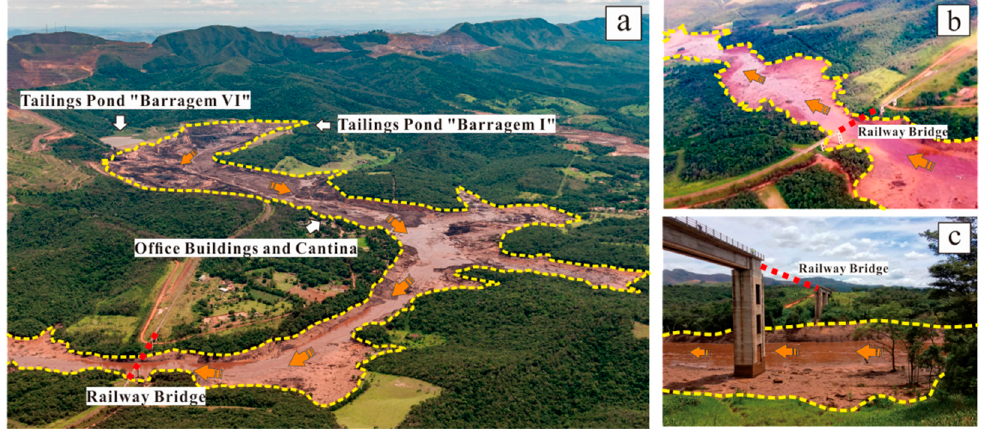
Figure 3. Disaster pictures. (a) Aerial view of Brumadinho dam disaster taken at 11:46 on 27 January 2019 [19]; (b) video screenshot of the destroyed railway bridge, 3 km downstream from the collapsed dam, on 26 January 2019 from YouTube [20]; (c) picture of iron ore railway bridge destroyed by mudflow taken on 26 January 2019 [21]. Note that the yellow line represents the extents of the areas affected by the mudflow, the red line represents the railway bridge which was damaged, and the brown arrow indicates the movement direction of the mudflow.